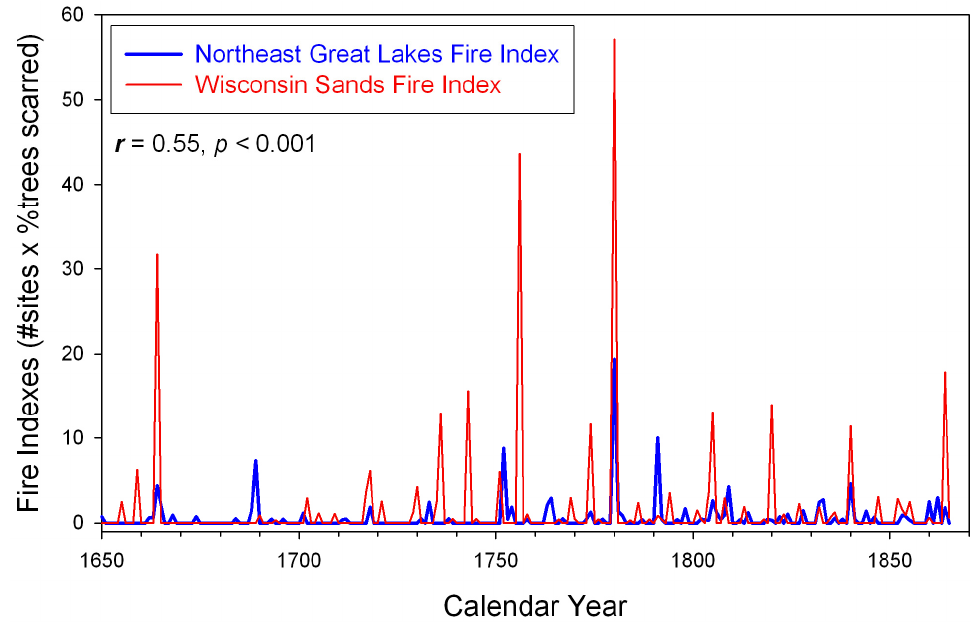
Figure 8. Comparison of the fire records from the Northwest and Northeast Sands Ecological Units of northern Wisconsin (98 trees, this study) plotted with separate fire records in the Great Lakes region including Ontario, Upper Peninsula of Michigan, and Minnesota (239 trees). Correlation analysis includes all years. Removal of no fire years increases the correlation coefficient.